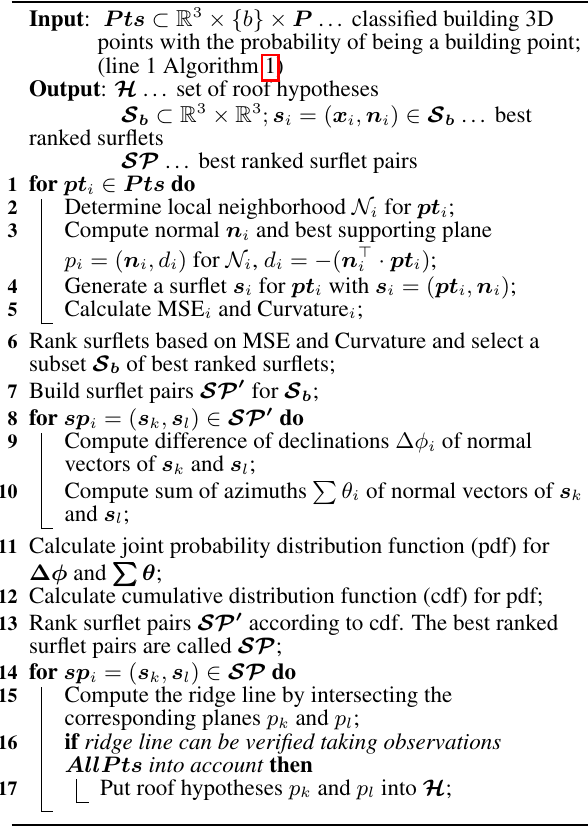
Algorithm 2: Pseudo-code of surflet-based active sam- pling for gabled roof hypotheses generation – GENERATE - GABLED ROOF HYPOTHESES